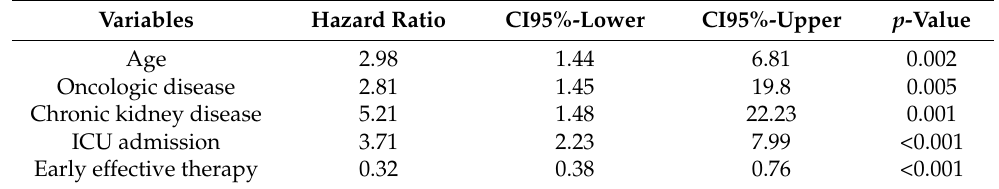
Table 3. Cox regression analysis on risk factors associated with 30-day mortality in all of study